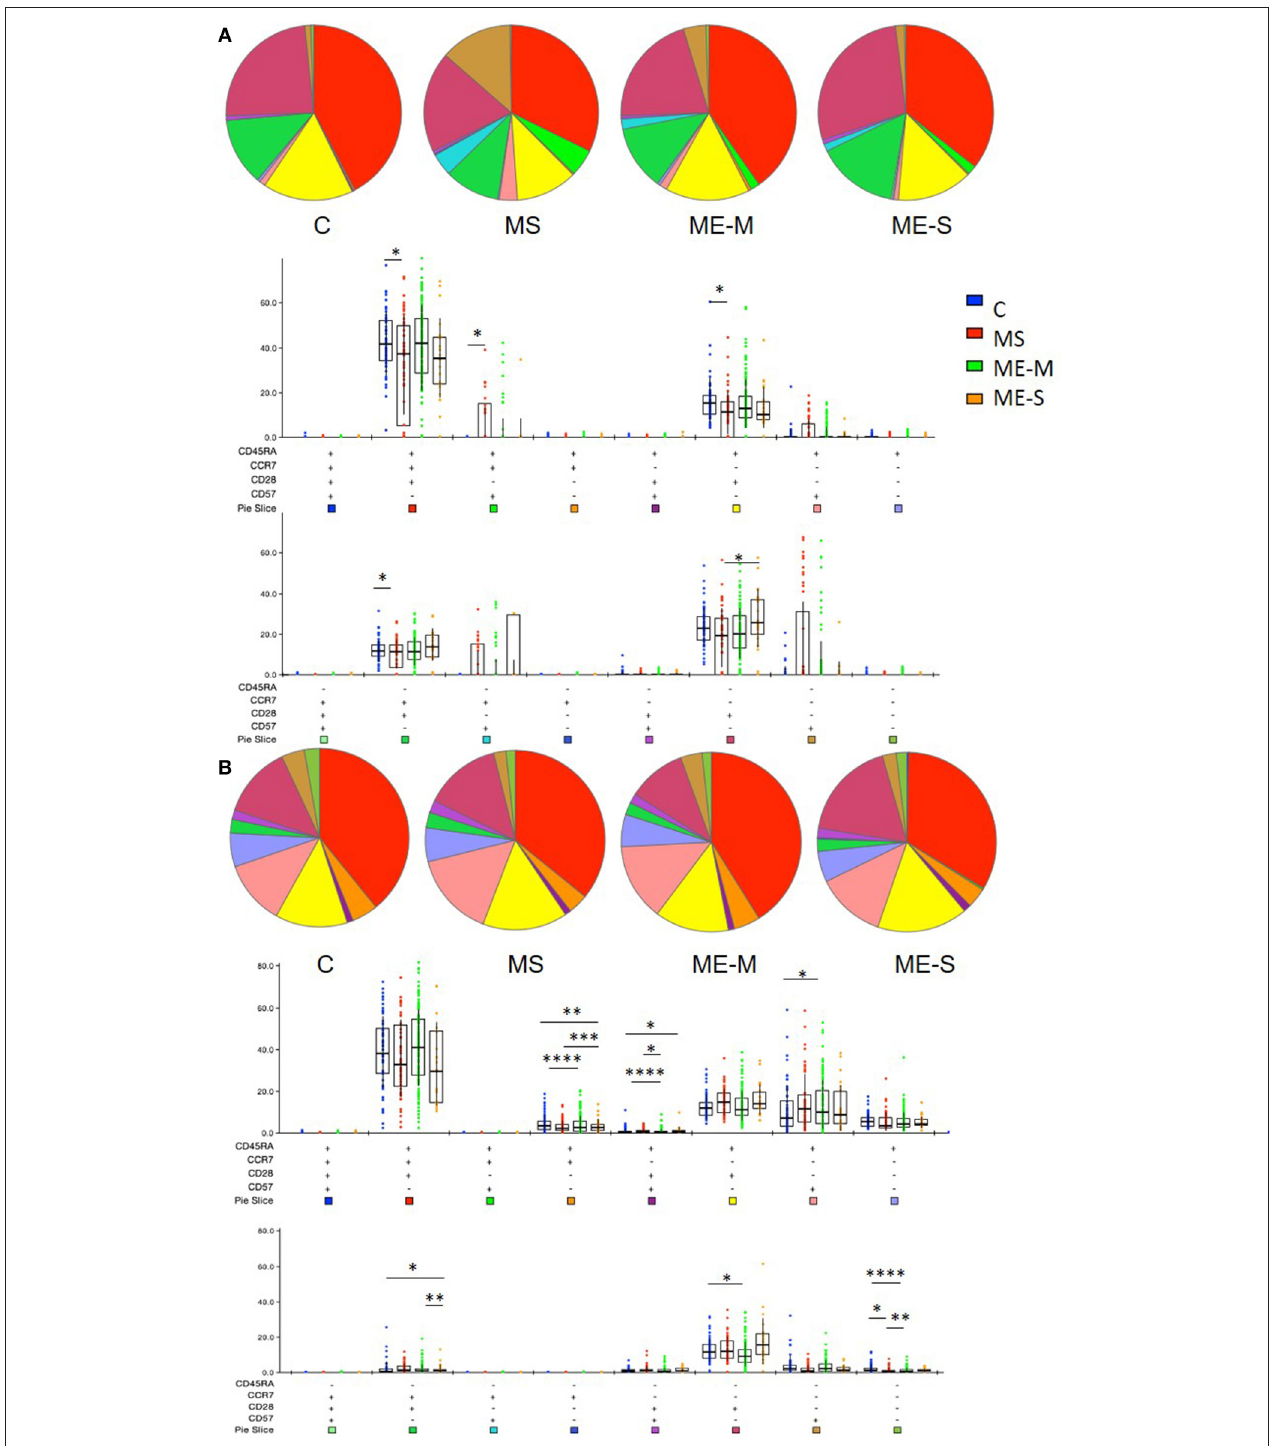
FIGURE 5 | Proportions of differentiated T cell populations in people with ME/CFS, people with MS and healthy controls. CD4 + (A) and CD8 + (B) T cells were analysed for CCR7, CD45RA, CD28, and CD57 co-expression to quantify proportions of T cells expressing combinations of these markers using FlowJo and SPICE software. The pie charts show the median proportions of each cell type in each clinical group. In the bar and whisker plots, cell populations were compared between clinical groups by Kruskal-Wallis test with Dunn’s correction for multiple comparisons for each cell differentiation subtype, with only significant ( P < 0.05) results shown. The colour under each cell phenotype bar chart shows its representation in the pie charts. Data are from C ( n = 56), MS ( n = 46), ME-M ( n = 120), and ME-S ( n = 21). * P < 0.05, ** P < 0.01, *** P < 0.001, **** P < 0.0001.